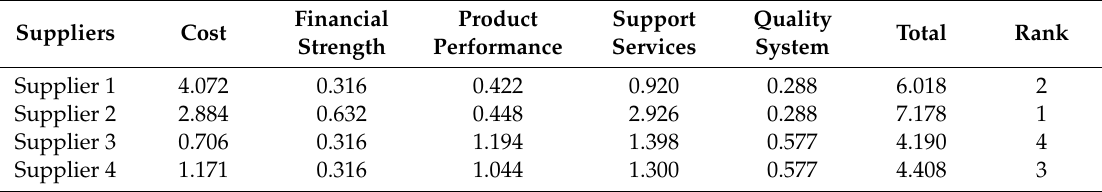
Table 10. The results of scores of the